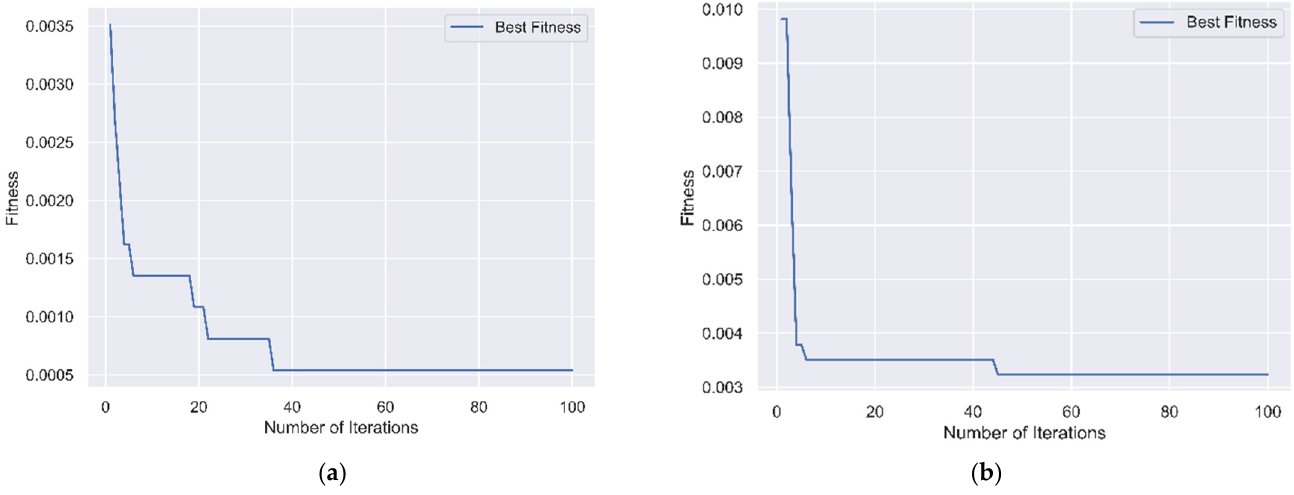
Figure 8. Loss curves of Invasive Weed Optimization. ( a ) Applying stator current signal ( I 2 ) ; ( b ) Applying the vibration signal.